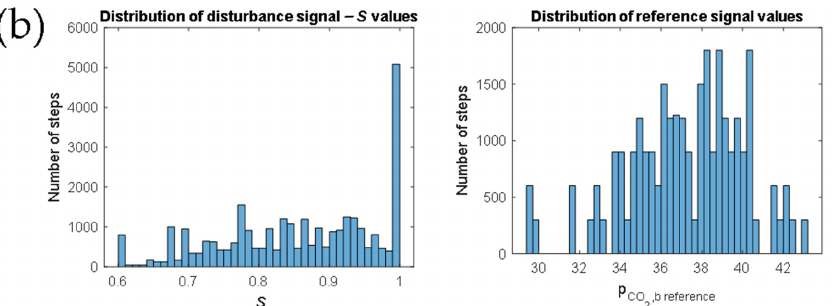
Figure 2. Statistics of the results of the experiments: ( a ) the distributions for the control action and reference tracking error for each controller; ( b ) distributions for the reference signal and the disturbance signal.